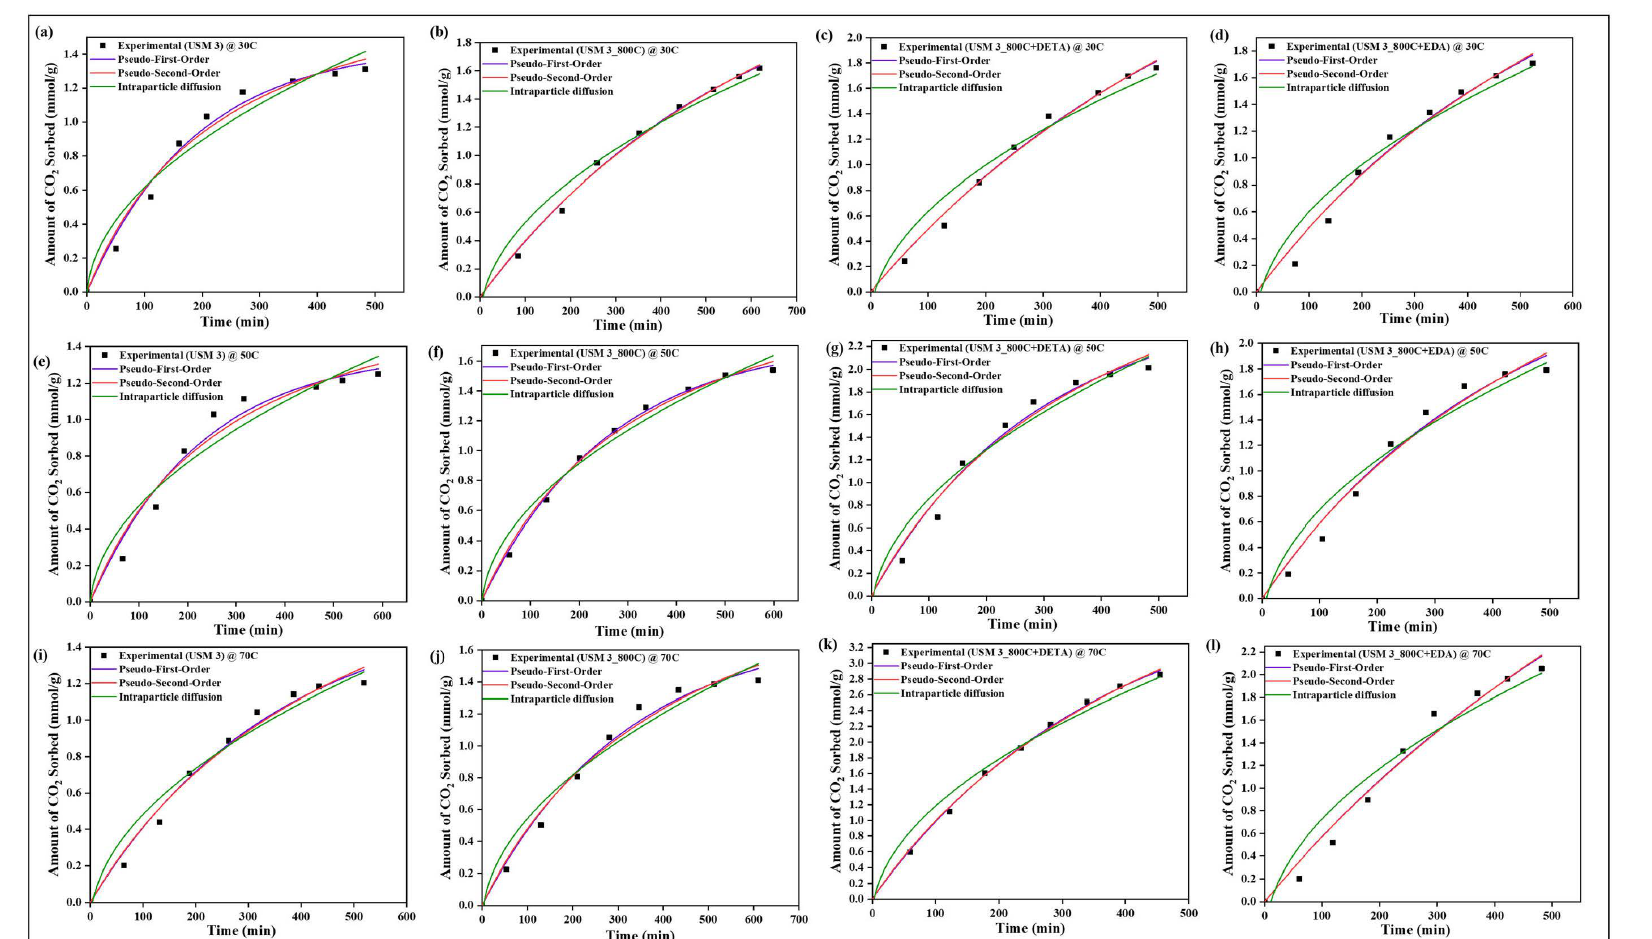
Figure 15. The prediction of sorption rate mechanism on USM 3 variants at 30 ◦ C ( a – d ), 50 ◦ C ( e – h ), and 70 ◦ C ( i – l